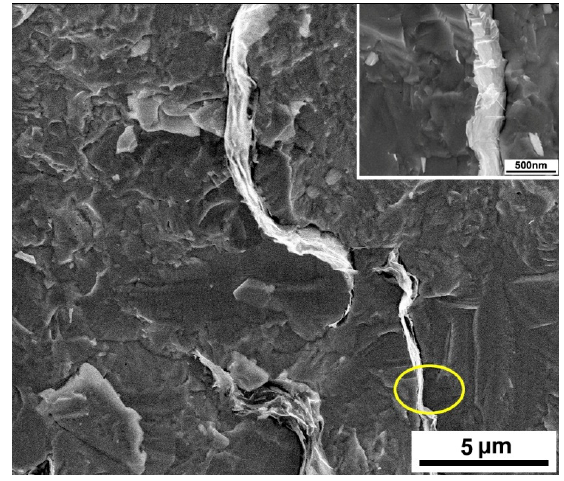
Figure 7. Field-emission SEM (FESEM) image of fractured surface of the sintered graphene/Cu 2 SnSe 3 sample.